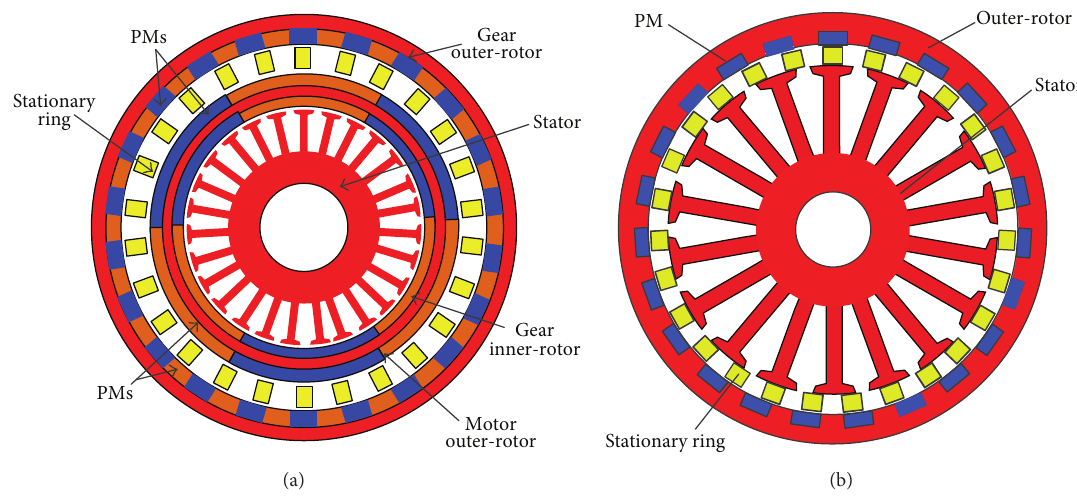
Figure 1: Configuration of magnetic-geared PM motor: (a) three air-gaps and (b) the proposed